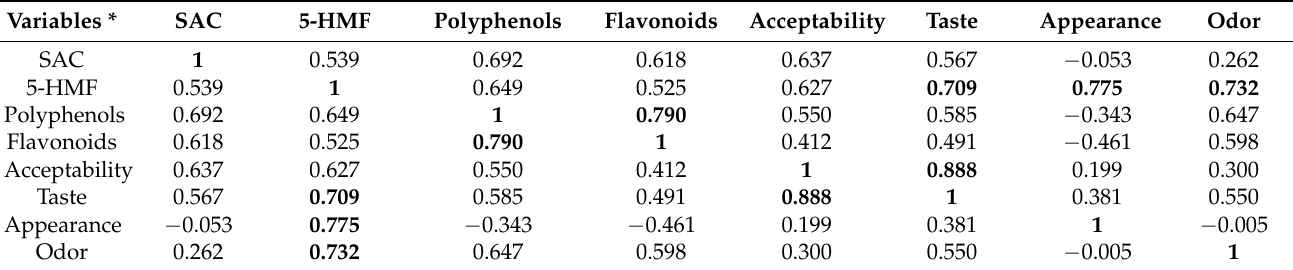
Table 2. Correlation of quality indicators of black